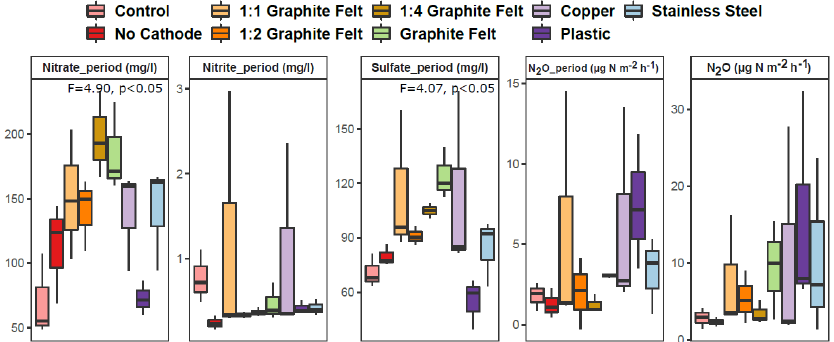
Figure 3. Box plots of water parameters and gas emissions in nine studied treatments. Statistically significant differences between groups considering different genes are shown with F and p values determined by multivariate analysis. The central line is the median, the edges of the box are the 25th and 75th percentiles, the whiskers represent the 95% confidence interval, and grey dots indicate outliers. Period denotes average values throughout the experiment (each n = 3). N 2 O_period denotes average N 2 O emission values throughout the experiment. N 2 O denotes N 2 O emission values directly before soil sampling (each n =